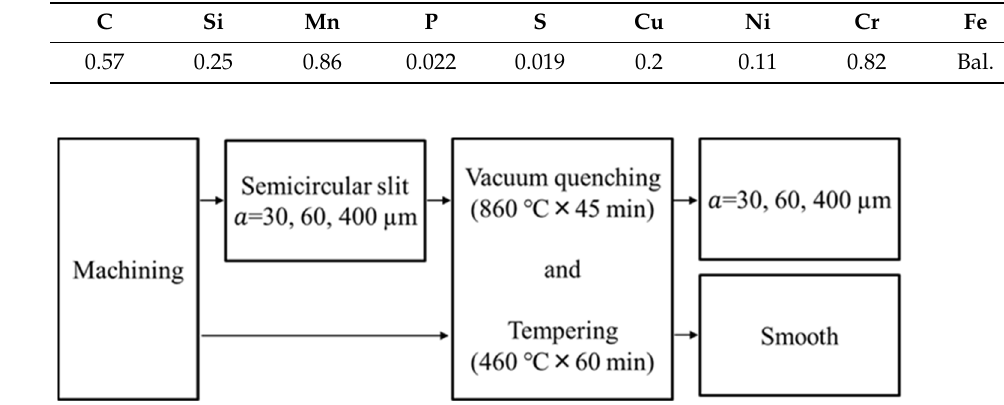
Figure 3. Flowchart of the process for fabricating test specimens.